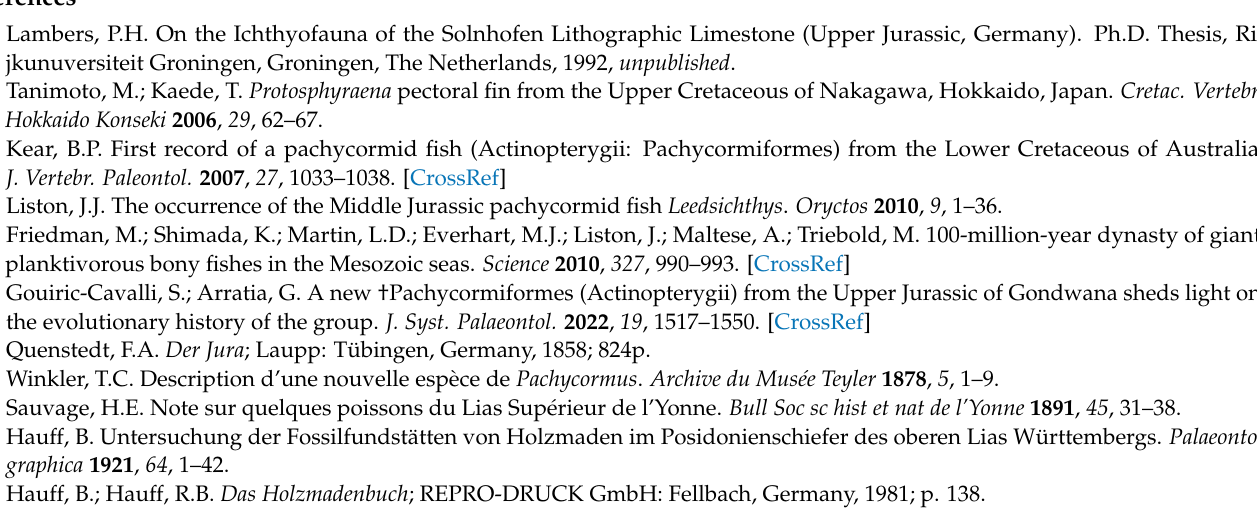
in Supplementary File S1: Figure S1 = Historic photograph of SMNS 15815 taken prior to 1944. Figure S2 = Caudal fin of Martillichthys renwickae Liston, NHMUK PV P. 61563. Figure S3 = Strict consensus of 12 trees based on the Friedman (2012) matrix. Figure S4 = Strict consensus tree from Friedman (2012) with Jackknife (36) applied. Figure S5 = Agreement subtree of the results from the Friedman (2012) matrix. Figure S6 = Strict consensus of 5 trees based on the Gouiric–Cavalli and Arratia (2022) matrix. Figure S7 = Strict consensus tree based on the Gouiric–Cavalli and Arratia (2022) ma-trix. Figure S8 = Agreement subtree of consensus tree produced using the Gouiric–Cavalli and Arratia (2022) matrix. Figure S9 = Ohmdenia multidentata Holotype–GPIT-PV-31531. Figure S10 = Gastrointestinal anatomy in two examples of Pachycormus. Supplementary File S2 Updated TNT file of the Friedman (2012) phylogenetic analysis matrix, including scoring for Germanostomus pectopteri gen. et sp. nov. Supplementary File S3 TNT file of the Gouiric–Cavalli and Arratia (2022) phylogenetic analysis matrix, with updated scoring for Saurostomus esocinus and Germanostomus pectopteri gen. et sp.